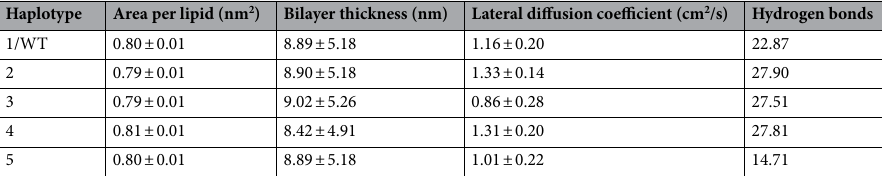
Table 5. The lipid bilayer parameters of the 1-palmitoyl-2-oleoylphosphatidylcholine (POPC) simulated lipid bilayer and hydrogen bonds formed between the protein and the POPC lipids.